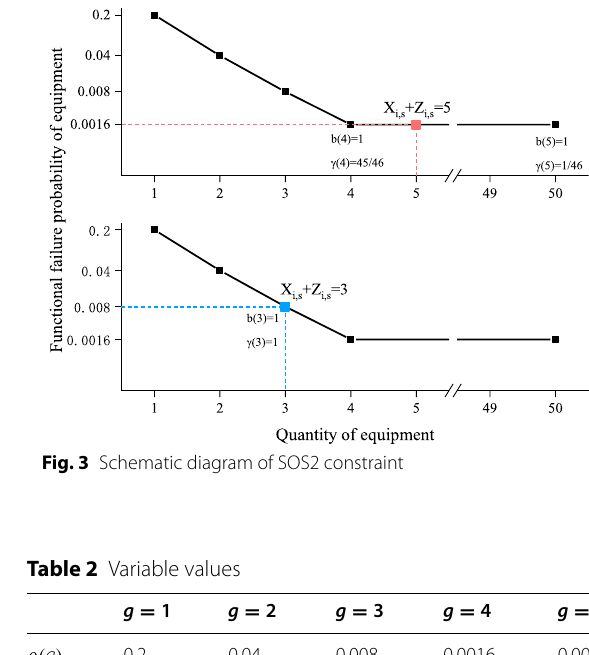
Fig. 3 Schematic diagram of SOS2 constraint